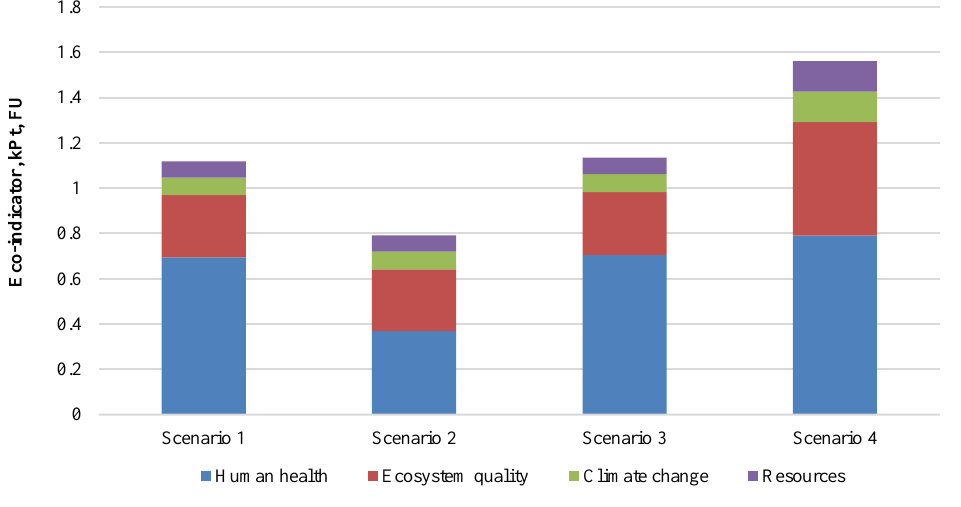
Fig. 1. Impact assessment score for